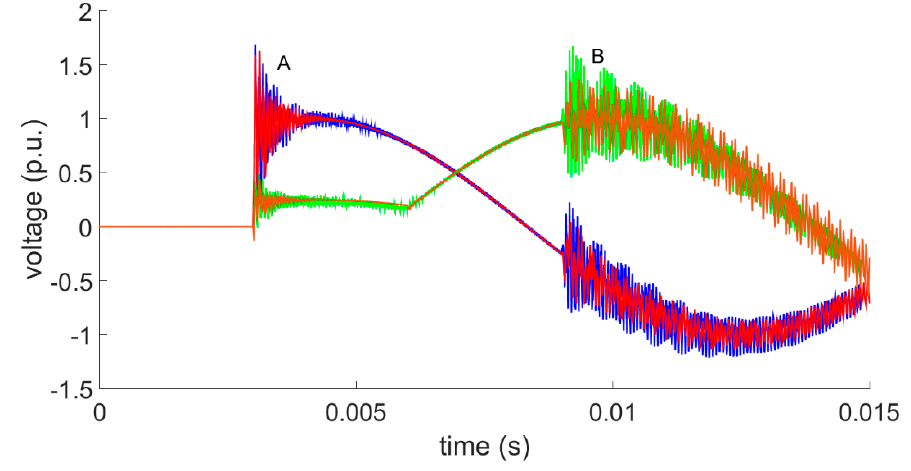
Figure 12. Comparison between the transient voltage computed with the proposed method (blue and green lines) and those obtained with ATP simulations (red and orange lines) in example 3.2. The comparisons are made at the middle of the transmission line (2500 m from the sending node) in phases A and B. A good level of agreement can be observed, but the ATP simulations needed a time step 50 times smaller than the proposed method in order to achieve such results.